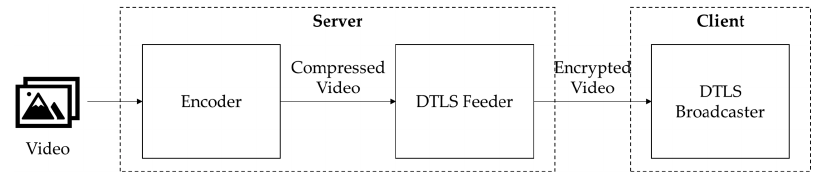
Figure 1. Datagram transport layer security (DTLS) encryption flow.